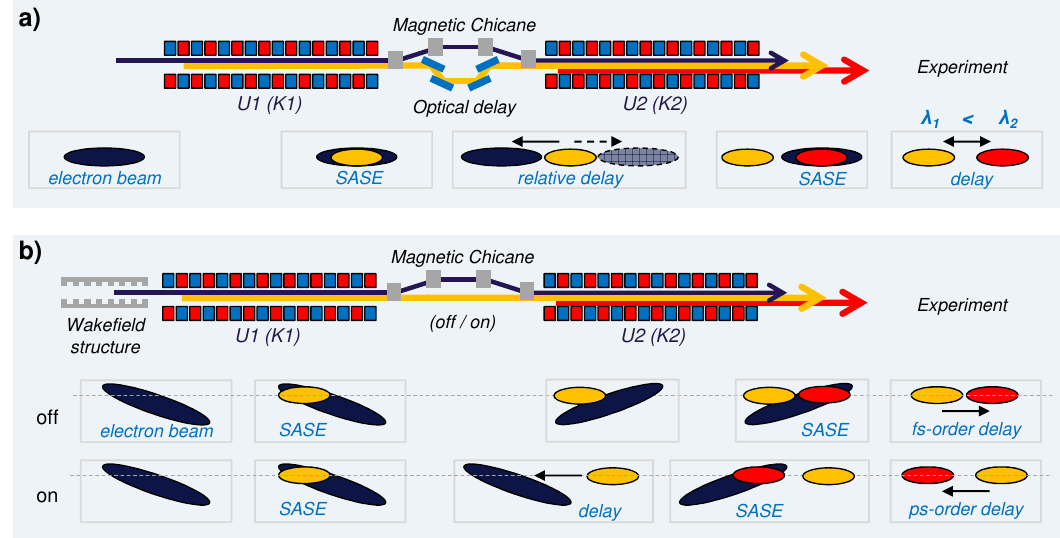
Figure 2. Solutions to obtain zero-crossing in the temporal delay by implementing an optical delay line ( a ) or a fresh-slice technique ( b